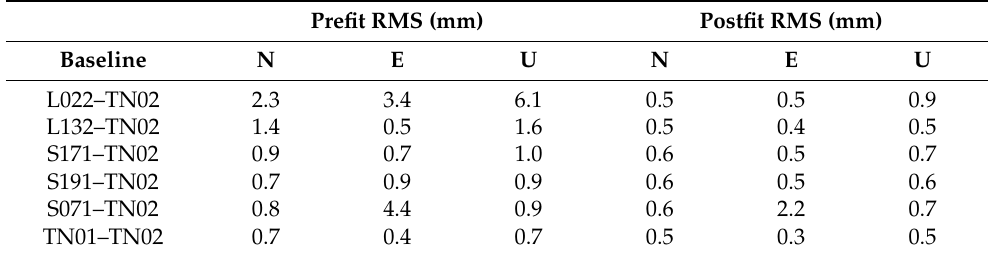
Table 4. Baseline RMS statistics (station-TN02) before and after removing the fitting models.